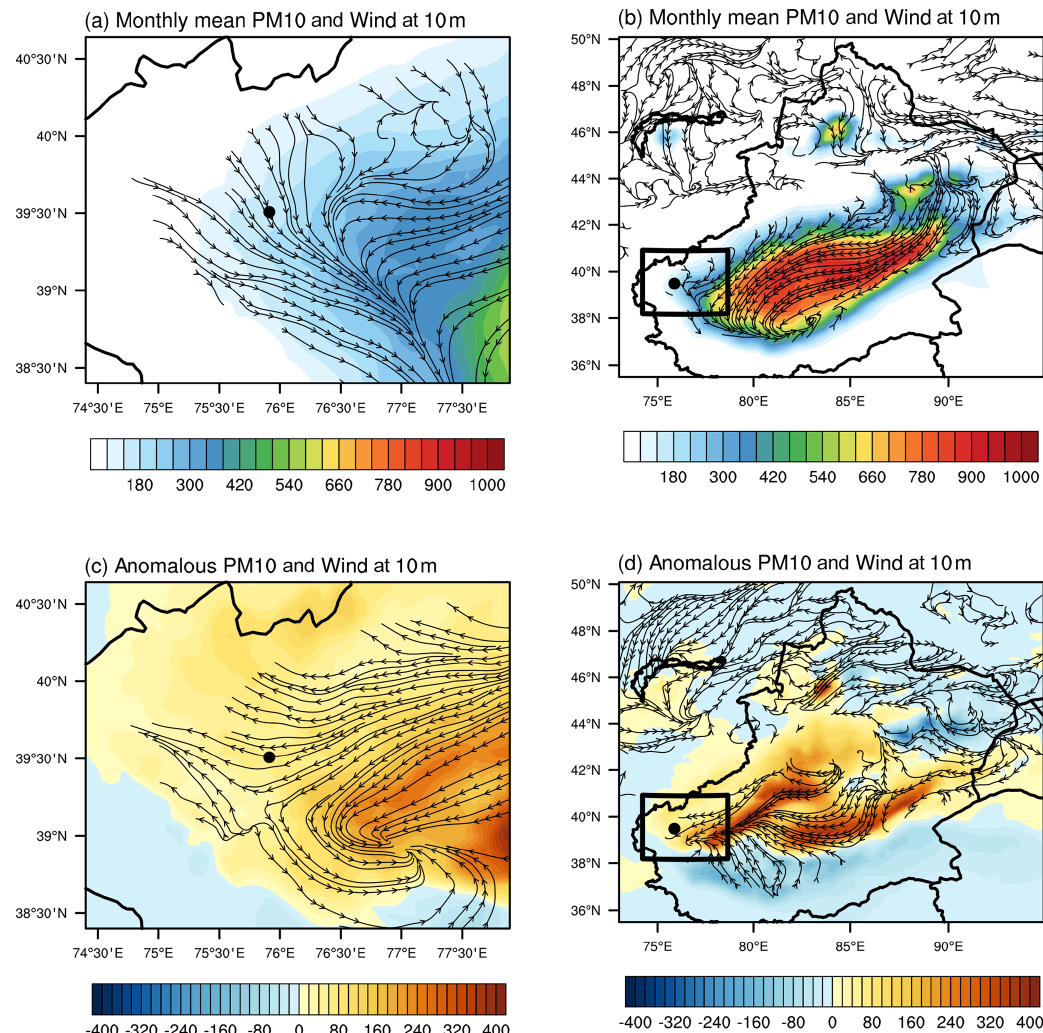
Figure 5. Monthly mean PM 10 concentration (µgm − 3 ) and the streamlines of the 10m wind (ms − 1 ) in April (a, b) and their daily mean anomalies (c, d) during a dust storm on 24 April to the monthly mean values. Only the streamlines at the topographical height lower than 2500m are shown for clarity. The rectangles in panels (b) and (d) denote the fine model domain 2, which was the geographical range in panels (a) and (c) . The black points indicate Kashi